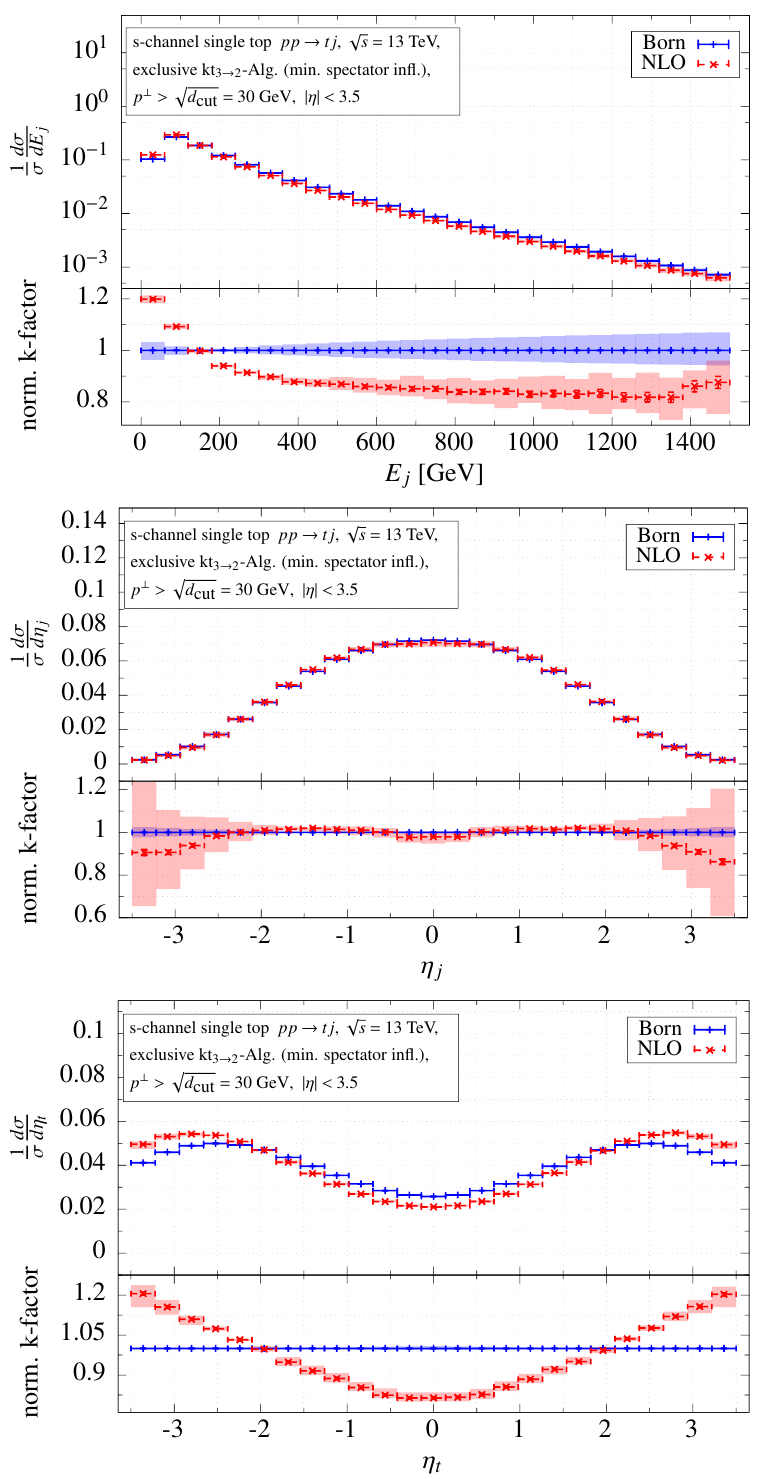
Figure 9 . Normalised distributions and k-factors for s -channel single top-quark production using the exclusive event de(cid:12)nition.